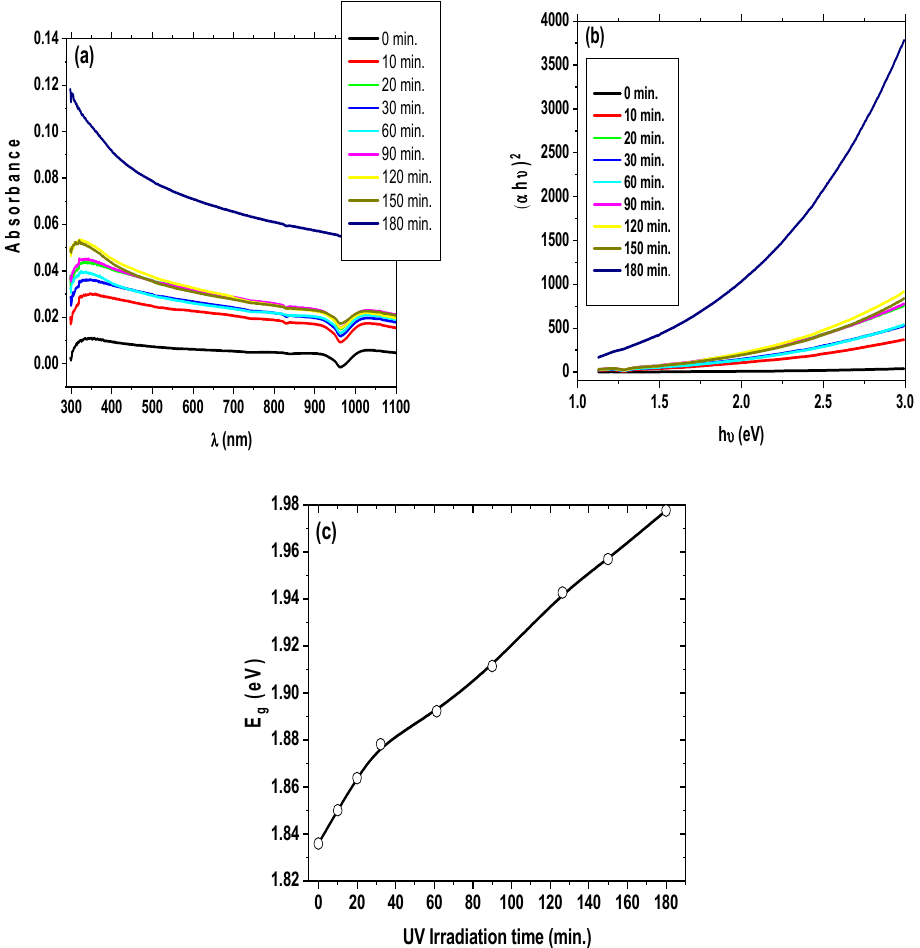
Figure 10. ( a ) Optical absorbance spectrum of the as-prepared silica nanoparticles under the effect of different irradiation times; ( b ) graph of ( α h ν ) 2 versus (h ν ) for exposing the prepared silica nanoparticles to UV light under different irradiation times; ( c ) variation of optical band gap energy of the as-prepared silica nanoparticles with different irradiation times.